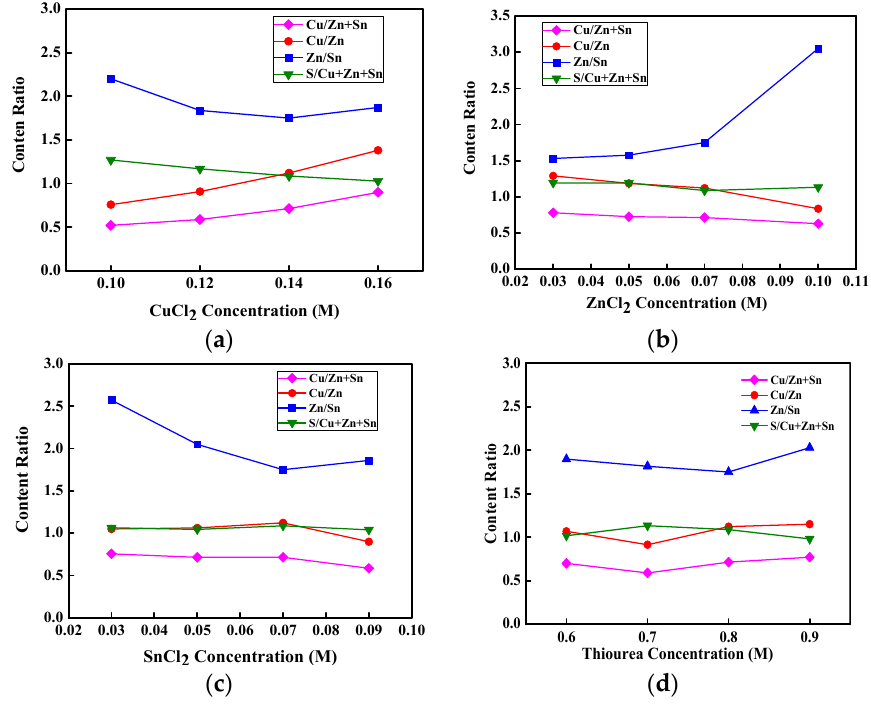
Figure 1. Atomic content ratios of Cu/(Zn + Sn), Cu/Zn, Zn/Sn, and S/(Cu + Zn + Sn) for copper-zinc-tin-sulfur (CZTS) thin films with ( a ) CuCl 2 ; ( b ) ZnCl 2 ; ( c ) SnCl 2 ; and ( d ) thiourea concentrations, respectively.